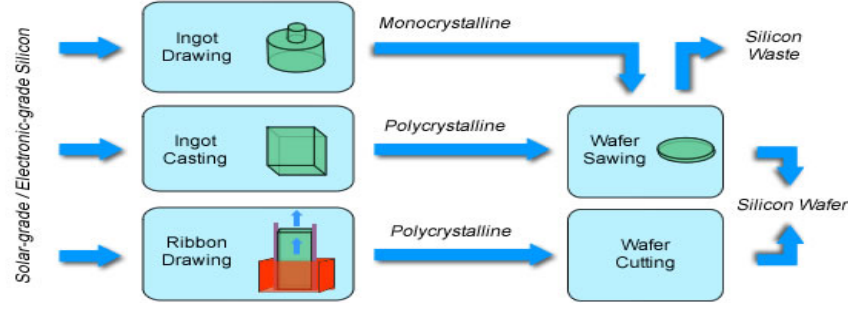
Fig. 2. Making silicon for CPU